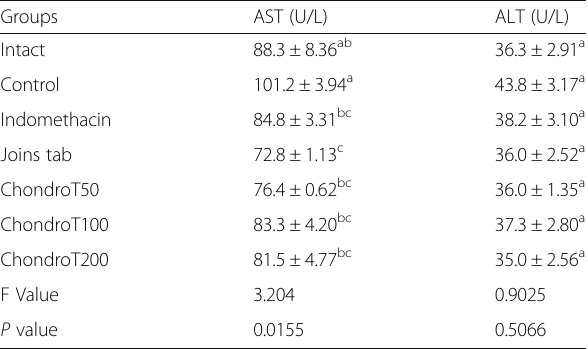
Table 5 Changes in serum aminotransferase content after ChondroT administration in collagenase-induced arthritis rats Groups